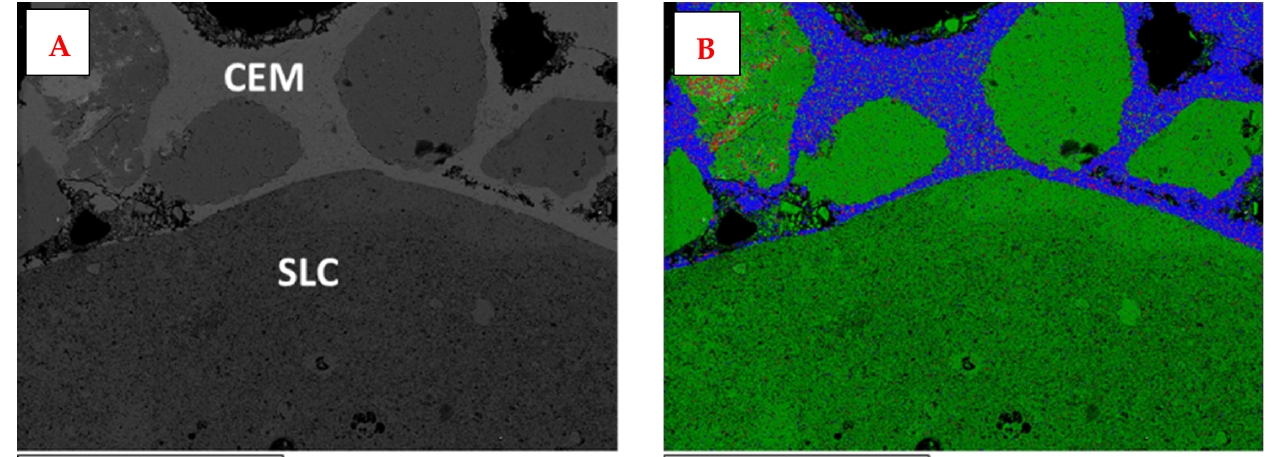
Figure 14. ( A ): BSE-SEM image indicating the cement phase to bond siliceous grains in matrix of sample. ( B ): Elemental mapping of Figure 14A for Si, Ca, Mg, presenting homogenous magnesium distribution in carbonate cement. Si: green color; Ca: blue color; Mg: red color; CEM: cement; SLC: siliceous rich lithoclast.